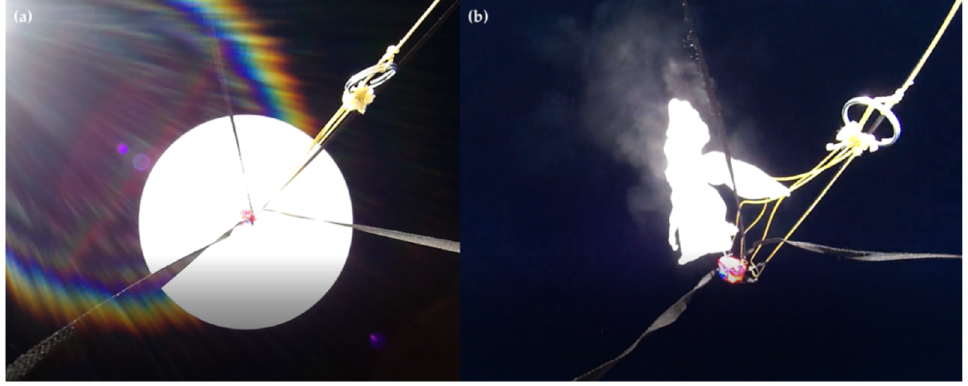
Figure 2. A latex balloon in the stratosphere at the maximum altitude of >23 km ( a ) and a few seconds later after the burst ( b ). In ( b ), above the burst envelope, a large helium-talc cloud can be noticed, with the talc being sloughed off the latex envelope and carried away by the released helium. The pictured balloon carried a Very Low Frequency test antenna dipole of 200 m in length, described in more detail in [4].